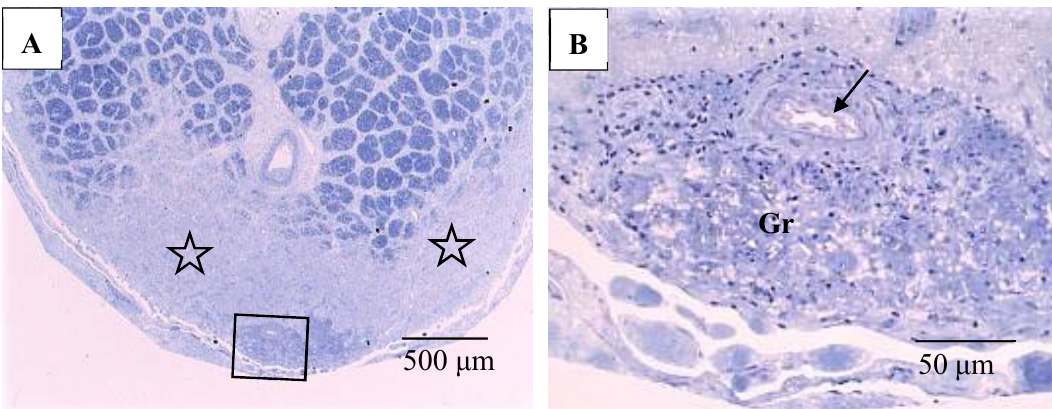
vitreous (Figure 15D), or vitreoretinal adhesion in the degenerated retina (Figure 15E), was sometimes observed in the peripheral retina.